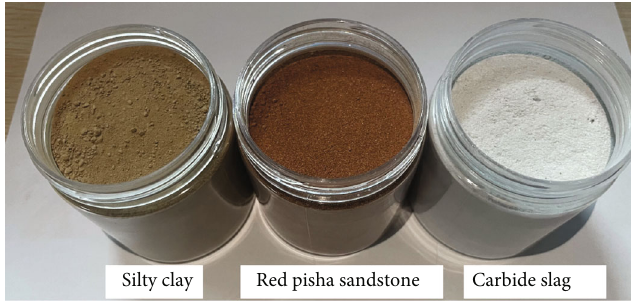
Figure 1: Raw test materials.